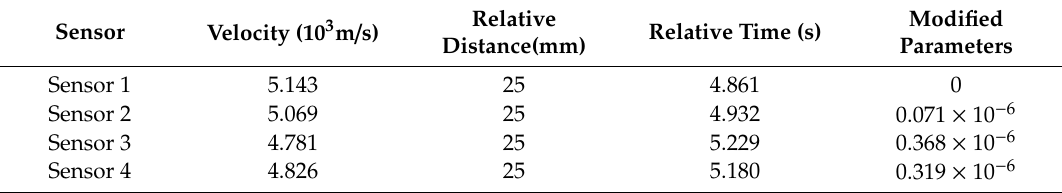
Table 1. Corrected parameters of acoustic